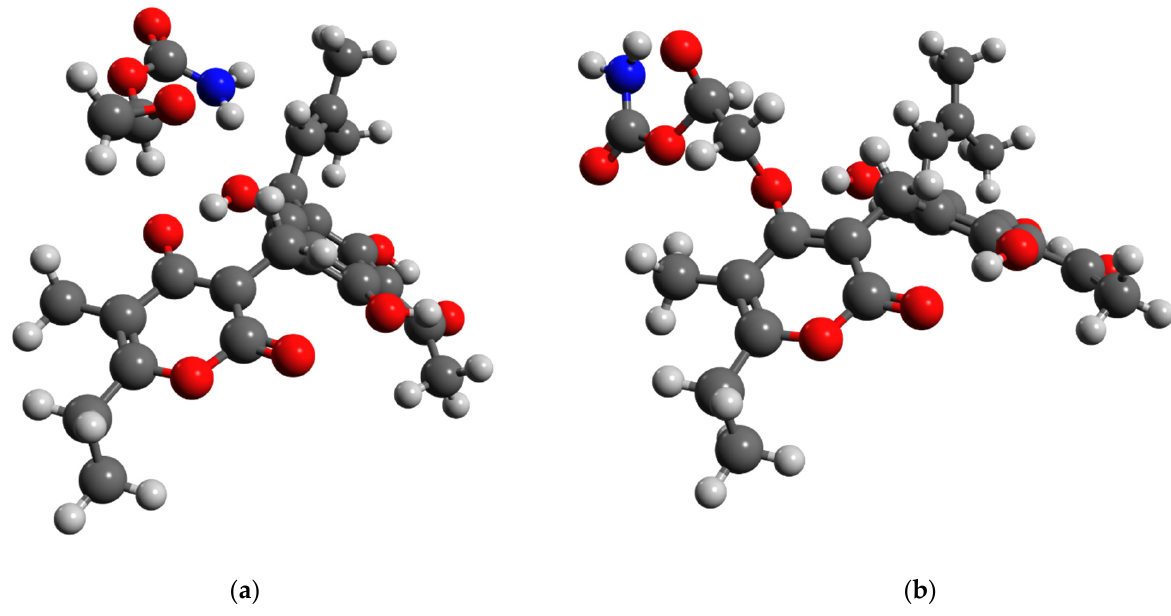
Figure 5. Quantum-mechanical models of ( a ) reactants and ( b ) transition state structure of the most studied compound from the Helichrysum italicum extracts–arzanol with vinyl carbamate epoxide obtained with Hartree-Fock method and flexible 6-311++G(d,p) basis set. Carbon atoms are depicted in grey, oxygen in red, nitrogen in blue and hydrogen atoms in